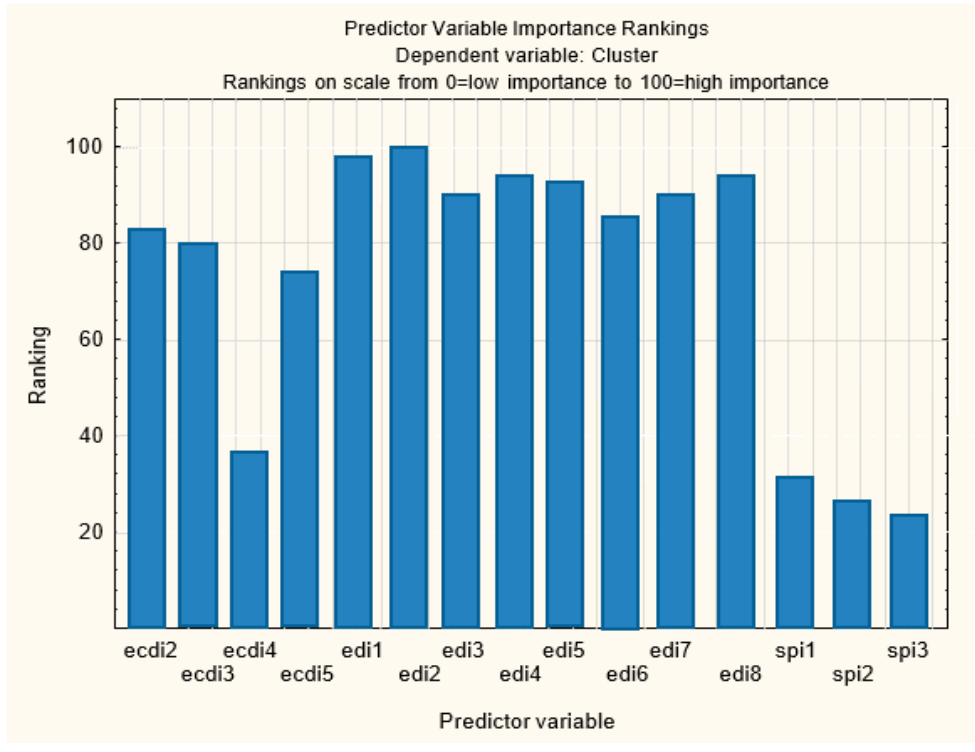
Figure 8. Ranking of indicators by influence on the clustering of countries, depending on the sus ‐ tainable energy development scenarios. Source: own